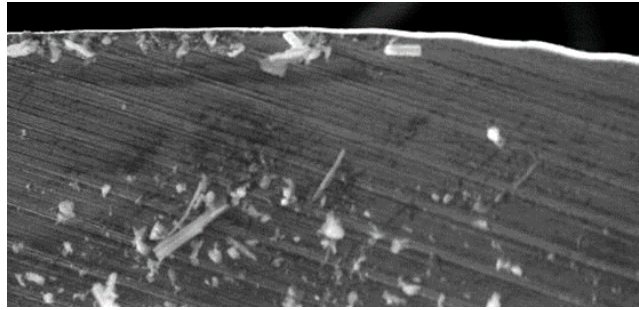
Figure 6. Detail of irregularities in the cutting edge of the tool.